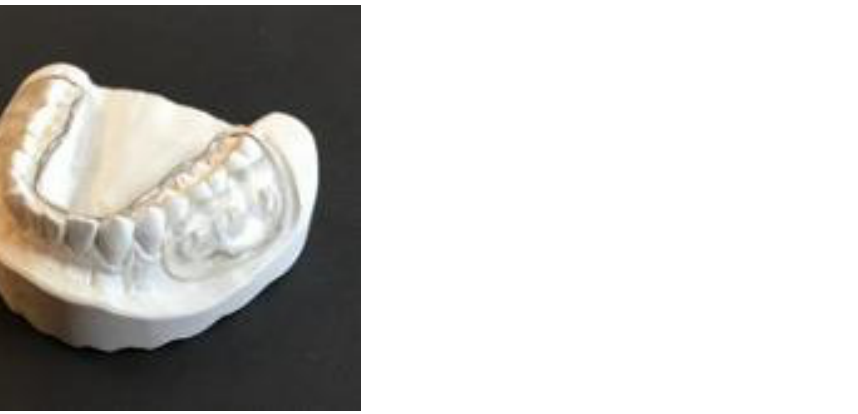
Figure 6. Individually-prepared intraoral lower jaw splint as a carrier for the material samples at the buccal sites of the lower premolars and the first molar.